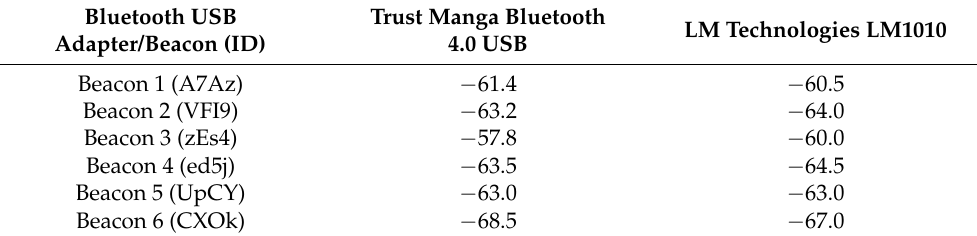
Table 9. Threshold values for the Bluetooth USB adapters, obtained in the Beacon Calibration Tool. All values are in